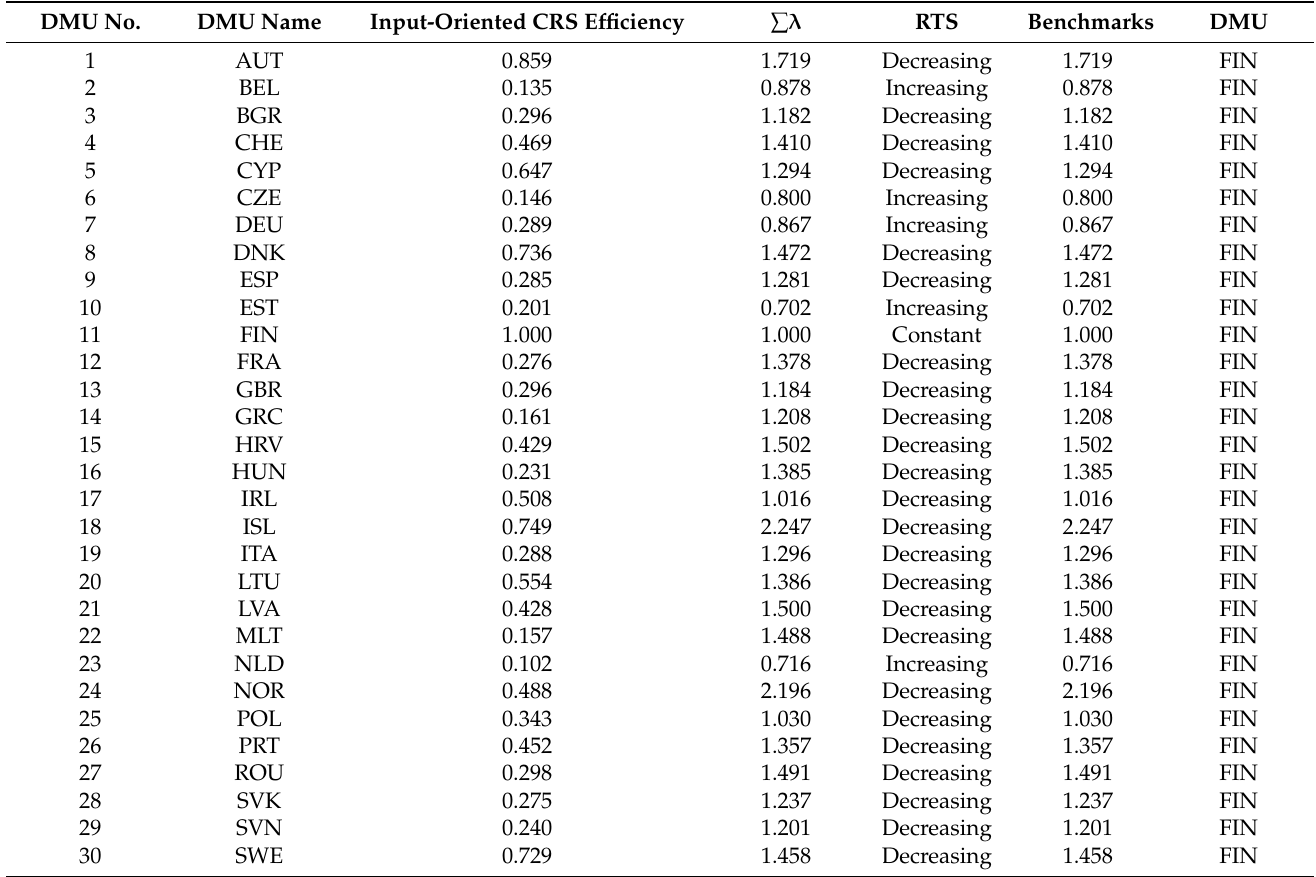
Table 3. Input-Oriented CRS Efficiency of EPS in 2015. Source: Authors’ calculations in DEAFrontier. DMU No.